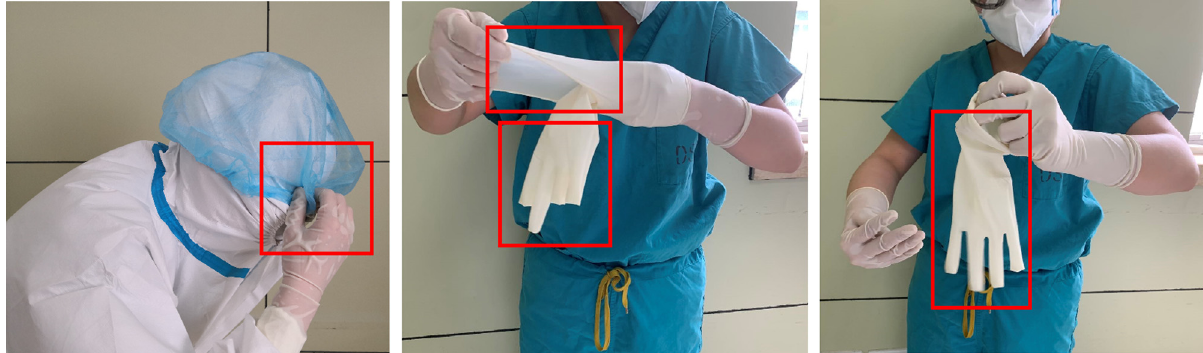
Figure 5: Representative images showing an inappropriate removal of surgical